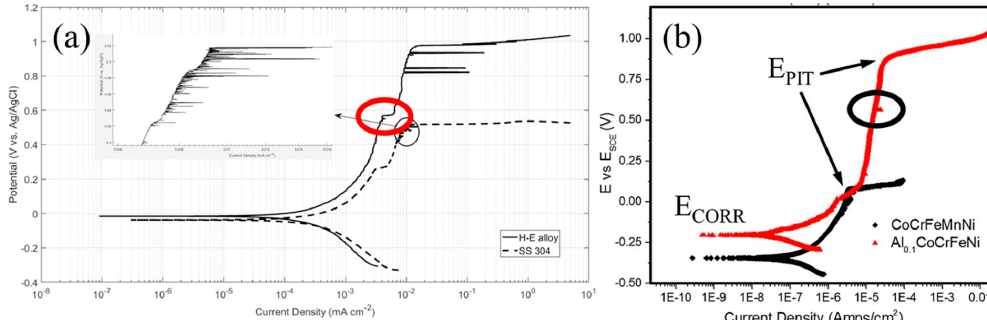
Figure 4. Potentiodynamic polarization curves of ( a ) as-cast Al 0.1 CoCrFeNi CCA versus SS304 steel in 3.5 wt% NaCl solution [32] ( b ) rolled and recrystallized Al 0.1 CoCrFeNi CCA as compared to CoCrFeMnNi CCA [31] (reprinted with permission from Elsevier).